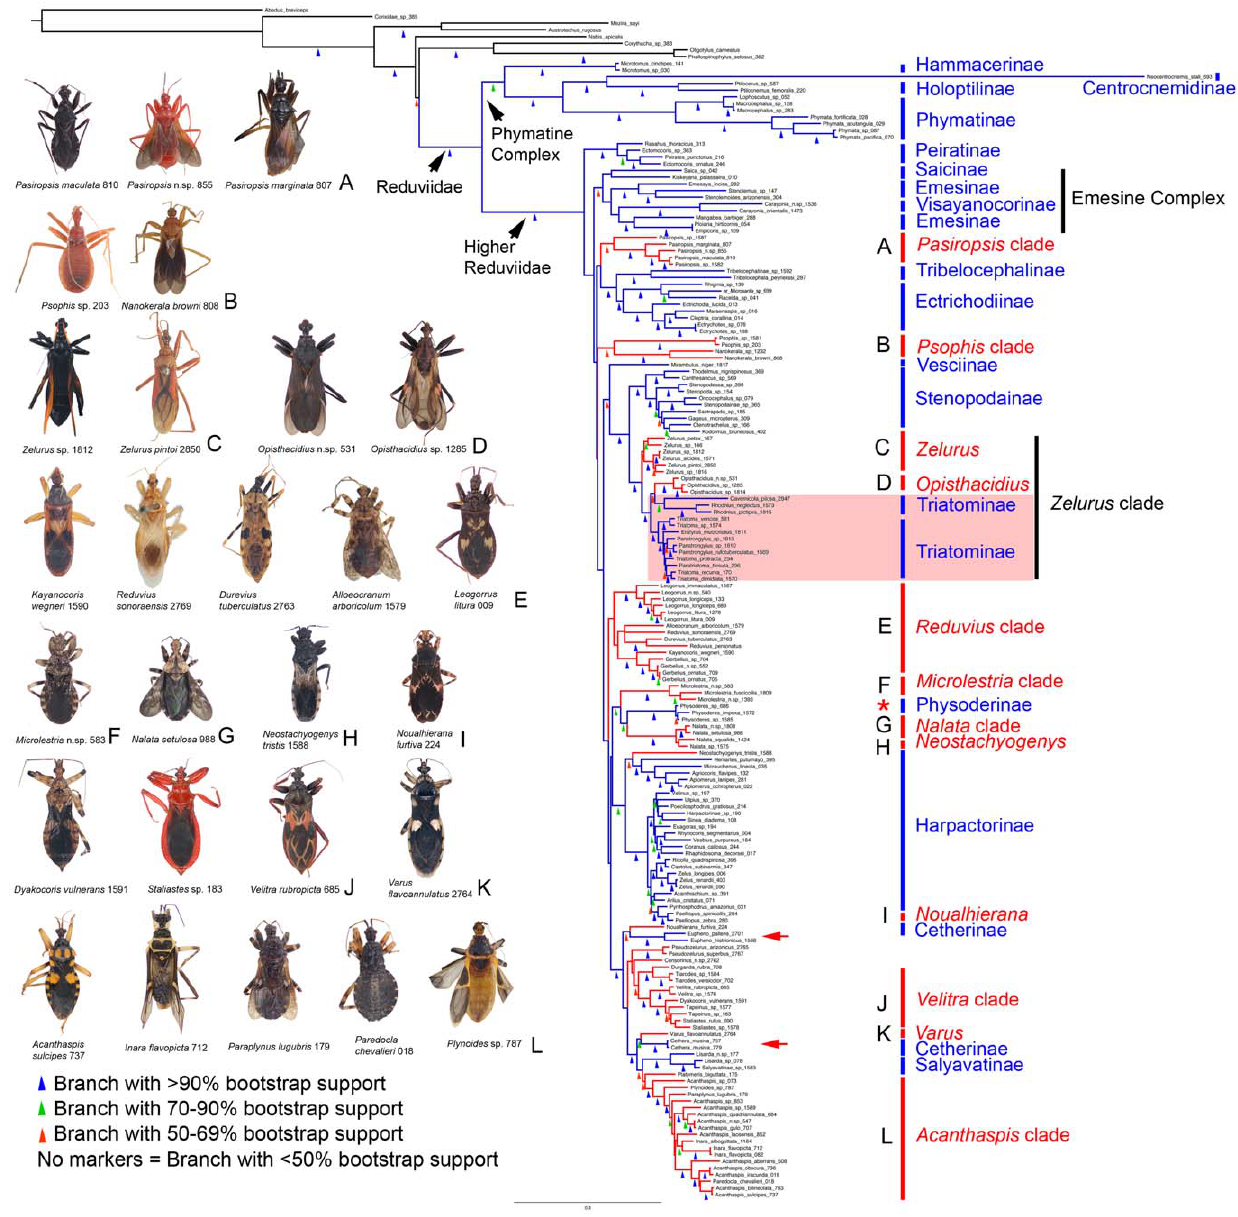
Figure 1. Maximum Likelihood phylogram with representative habitus images of reduviine clades. Best tree (score= 2 83447.290932) based on RAxML analysis of 178 taxa using a partitioned molecular dataset of 5 gene regions (16S, 18S, 28S D2, 28S D3–D5, Wg) aligned with MAFFT G-INS-i. Bootstrap values are indicated on branches by colored triangles according to support strength (explained by inset). Reduviinae lineages are indicated as red branches and remaining reduviids as blue while outgroup taxa are black. Habitus images of Reduviinae species with RCW specimen ID numbers are grouped (A–L) according to the 11 separate reduviine clades. The shaded red box highlights members of the hematophagous Triatominae, here shown as paraphyletic. Red arrowheads refer to the polyphyletic Cetherinae; the asterisk refers to Physoderinae nested within a reduviine clade.